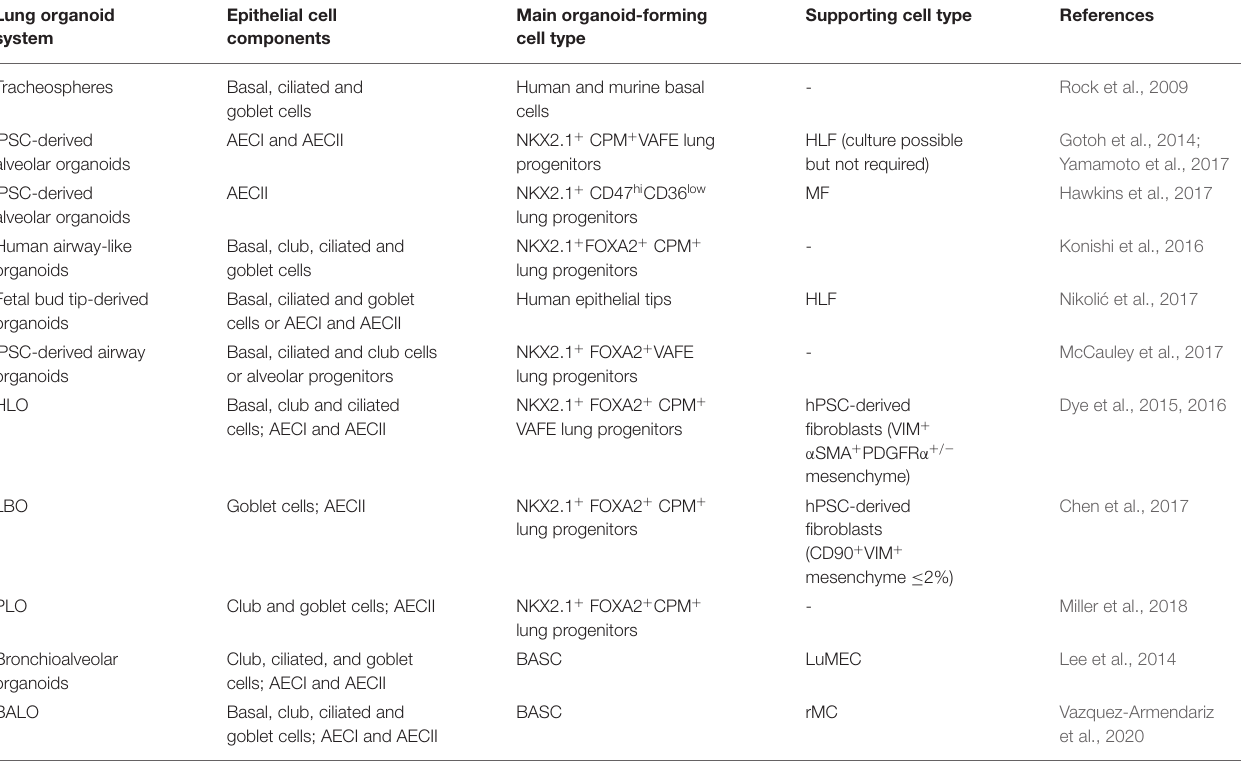
TABLE 1 | Murine and human lung organoid models mimicking features of lung development in vitro